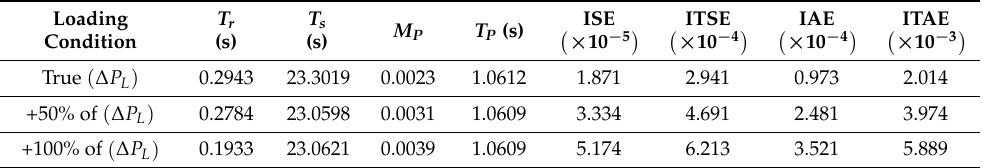
Table 4. Comparative study of dynamic responses offered by the HPSREG under varying load- ing